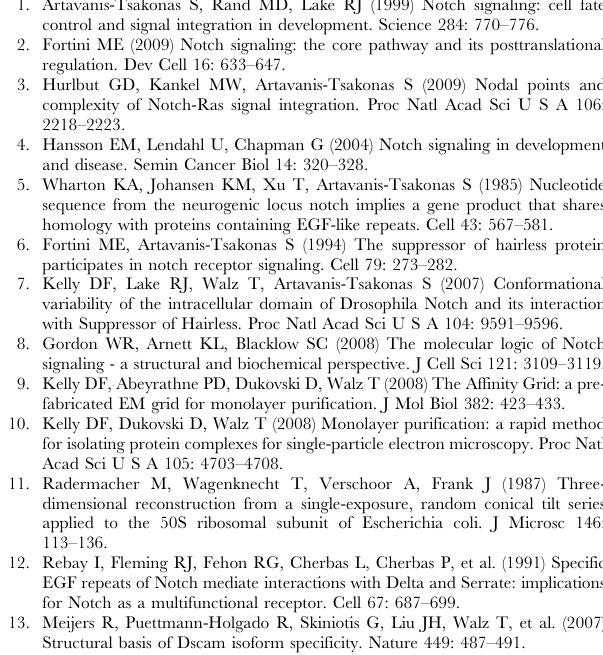
Figure S1 Averages obtained by classifying 6917 particle images of negatively stained Drosophila NECD into 20 classes. The side length of the individual panels is 43 nm. Figure S2 (A) Images of untilted (left panel) and 50 u tilted (right panel) specimens of Drosophila NECD in cryo-negative stain. Circles indicate individual particles. Black line indicates tilt axis. (B) Averages obtained by classifying the 13,802 particles selected from the images of untilted specimens of cryo-negatively stained Drosophila NECD into 20 classes. The side length of the individual panels is 43 nm.